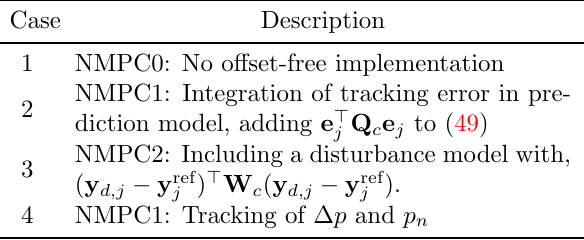
Table 5: Simulation case studies.